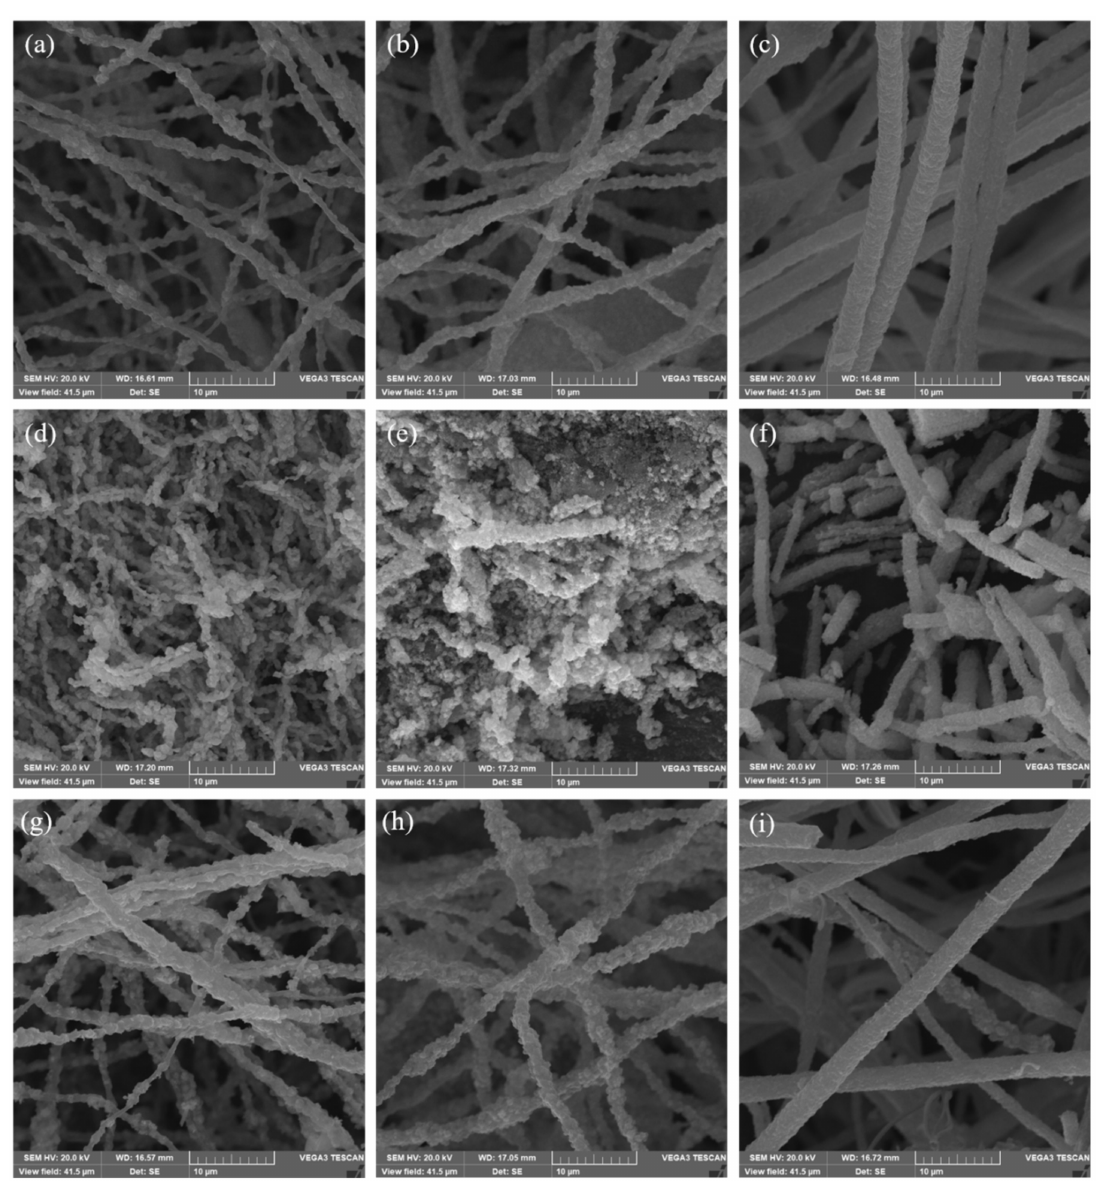
Figure 4. The SEM images of multi-doped porous carbon nanofibers derived from different Ni x Co y - ZIFs/PAN nanofibers by carbonization, oxidation, and sulfurization in different atmospheres (Ar, Air, and H 2 S): ( a ) Ni 1 Co 1 -ZIFs/PAN-Ar, ( b ) Ni 1 Co 2 -ZIFs/PAN-Ar, ( c ) Ni 1 Co 4 -ZIFs/PAN-Ar; ( d ) Ni 1 Co 1 - ZIFs/PAN-Air, ( e ) Ni 1 Co 2 -ZIFs/PAN-Air, ( f ) Ni 1 Co 4 -ZIFs/PAN-Air; ( g ) Ni 1 Co 1 -ZIFs/PAN-H 2 S, ( h ) Ni 1 Co 2 -ZIFs/PAN- H 2 S, ( i ) Ni 1 Co 4 -ZIFs/PAN- H 2